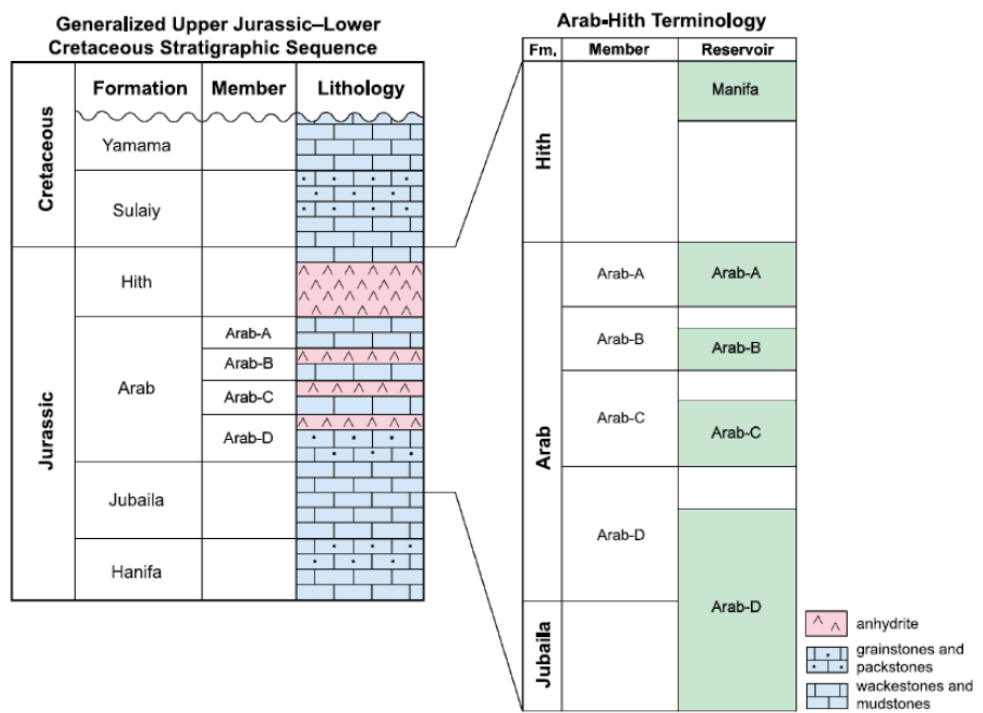
Figure 3. General different geological layers, showing in detail the Arab-Hith layers and the location of the simulated Arab-D (reprinted/adapted with permission from